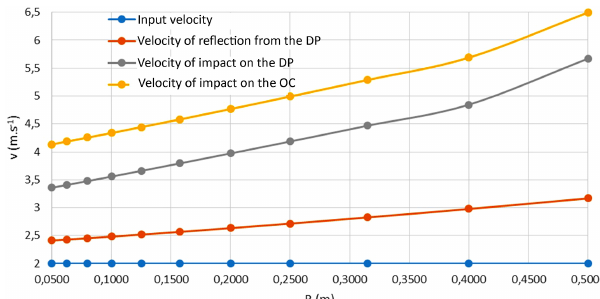
Figure 8. Graph of the velocity change for the material particle at v 1 = 2ms − 1 .